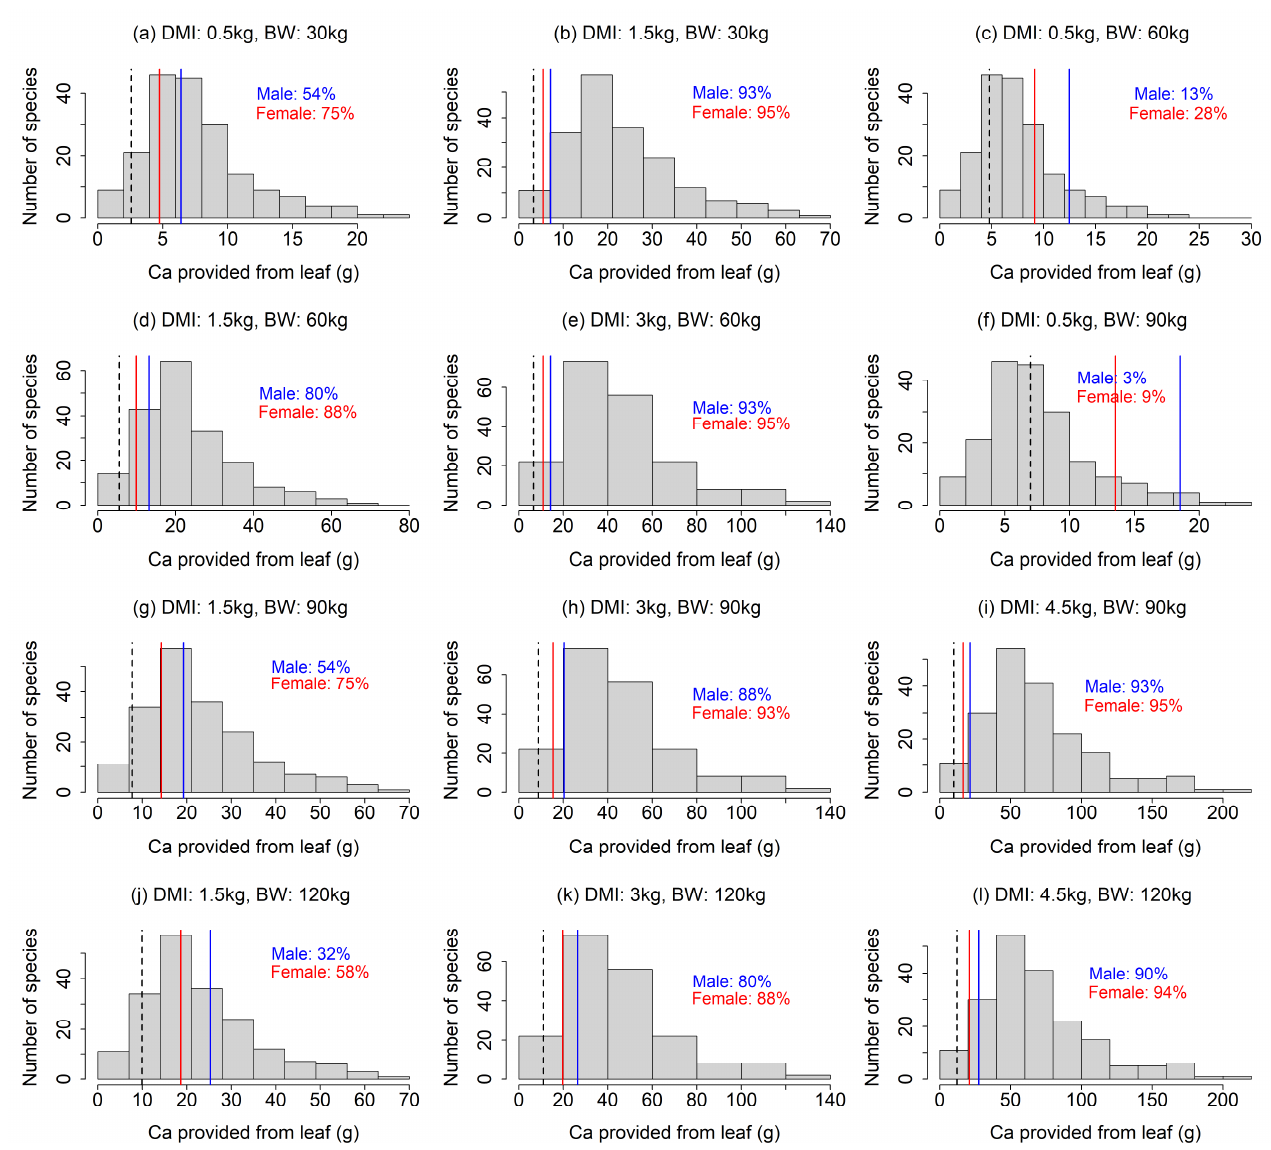
Figure 4. ( a – l ) Comparison between Ca provision via feed plants and the Ca requirement of sika deer under the 12 scenarios (four dry matter intake levels × four body weights, excluding unrealistic scenarios). The histogram is the distribution of Ca provision calculated from leaves of feed plant species. The solid lines indicate the Ca requirements of male (blue) and female (red) sika deer. Dashed line indicates the Ca requirement of females during the non-lactating period, which is equal to the Na maintenance requirement for both males and females. In the figures, the percentage is the proportion of feed plant species that met the Ca